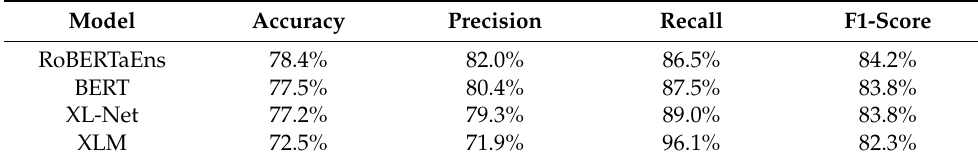
Table 3. RoBERTaEns model accuracy results compared to BERT, XL-NET, and